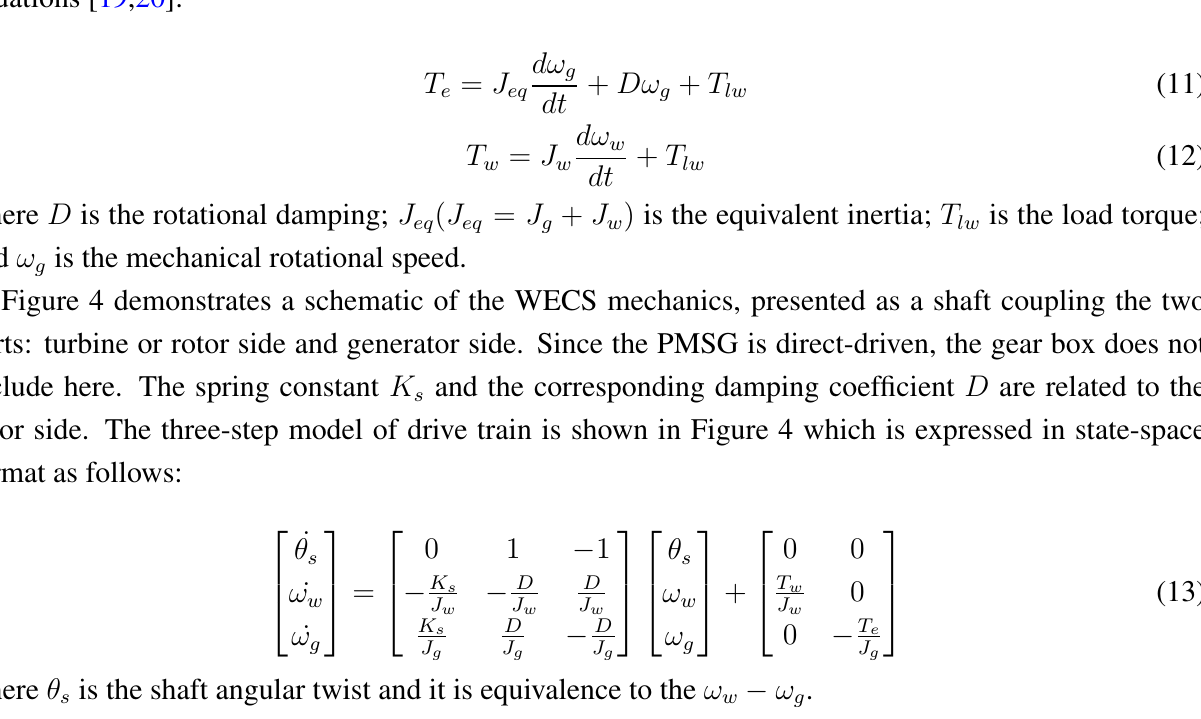
Figure 4. Two-mass shaft model of WECS. Rotor side Generator DKs